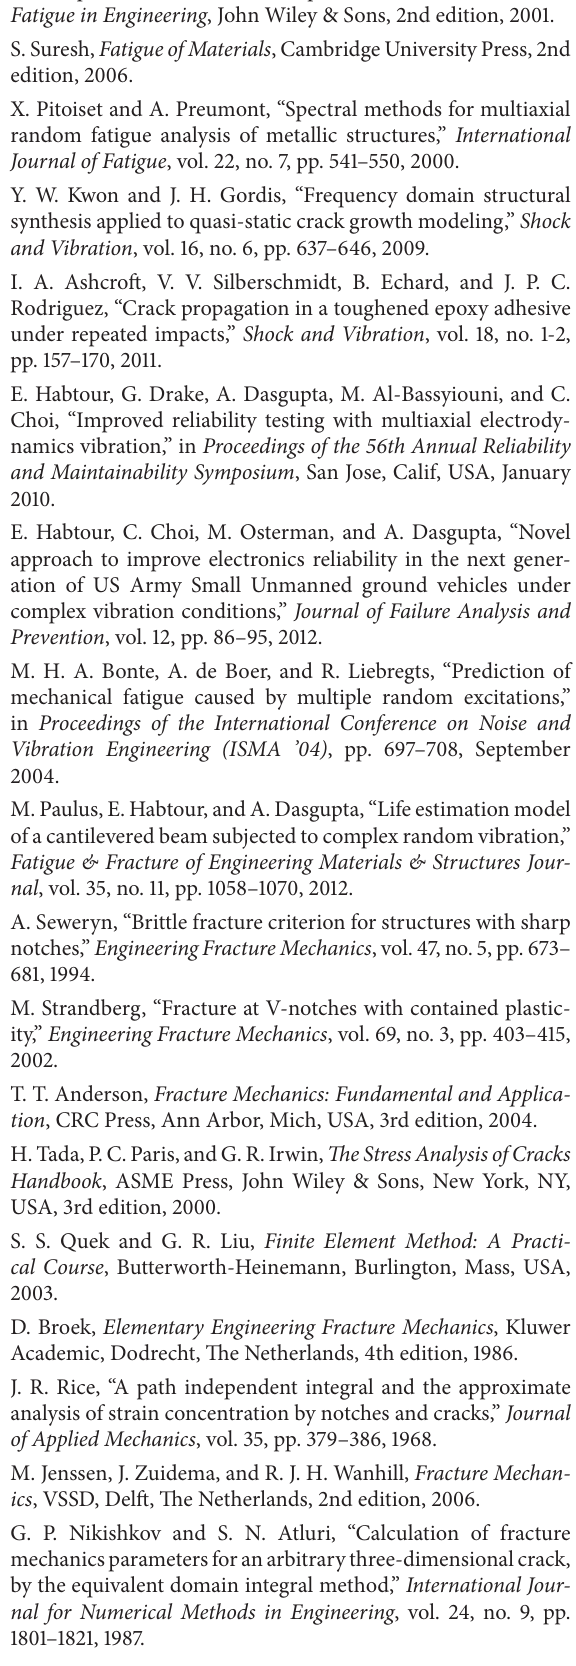
Table 1: FEM and analytical 𝐾 𝐼,